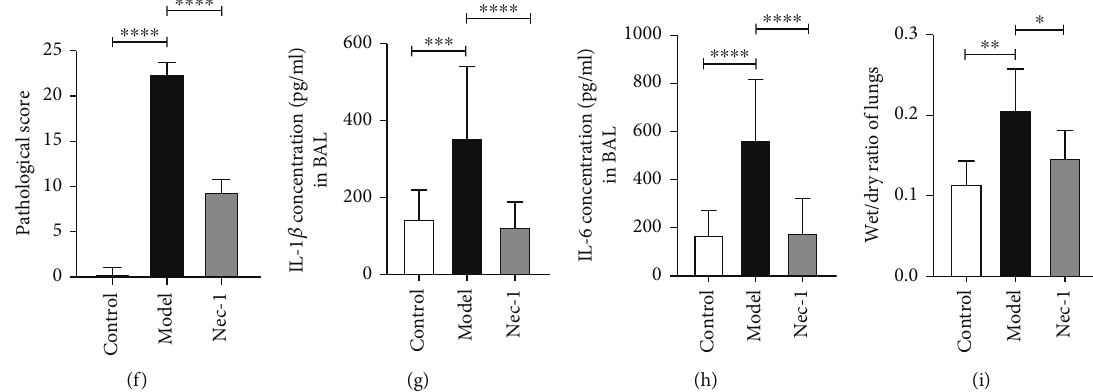
Figure 3: Nec-1 alleviated lupus pulmonary haemorrhage. (a) The modelling process of C57BL/6 mice. Model and Nec-1 group mice received the same dose of pristane/phosphate-bu ff ered saline (PBS) via intraperitoneal injection (i.p.) on day 0, followed by daily i.p. injection of PBS/Nec-1 until sacri fi ce on day 14. (b) The weight-change trends of mice in di ff erent groups. (c) Survival curves of mice in di ff erent groups. (d) Morphology of lung tissues in di ff erent groups. (e) Representative images of the haematoxylin and eosin-stained lung tissues of mice from di ff erent groups. (f) Pathological staining score of mice lung tissue from di ff erent groups. (g, h) Levels of IL-1 β and IL-6 in the bronchoalveolar lavage from di ff erent groups. (i) Wet/dry weight ratio of the mice lung tissue of di ff erent groups was calculated using ImageJ. Data are presented as mean ± standard deviation. Values are expressed as mean ± standard error of the mean of three independent experiments ( ∗ P < 0 : 05 , ∗∗ P < 0 : 01 , ∗∗∗ P < 0 : 001 , and ∗∗∗∗ P < 0 : 0001